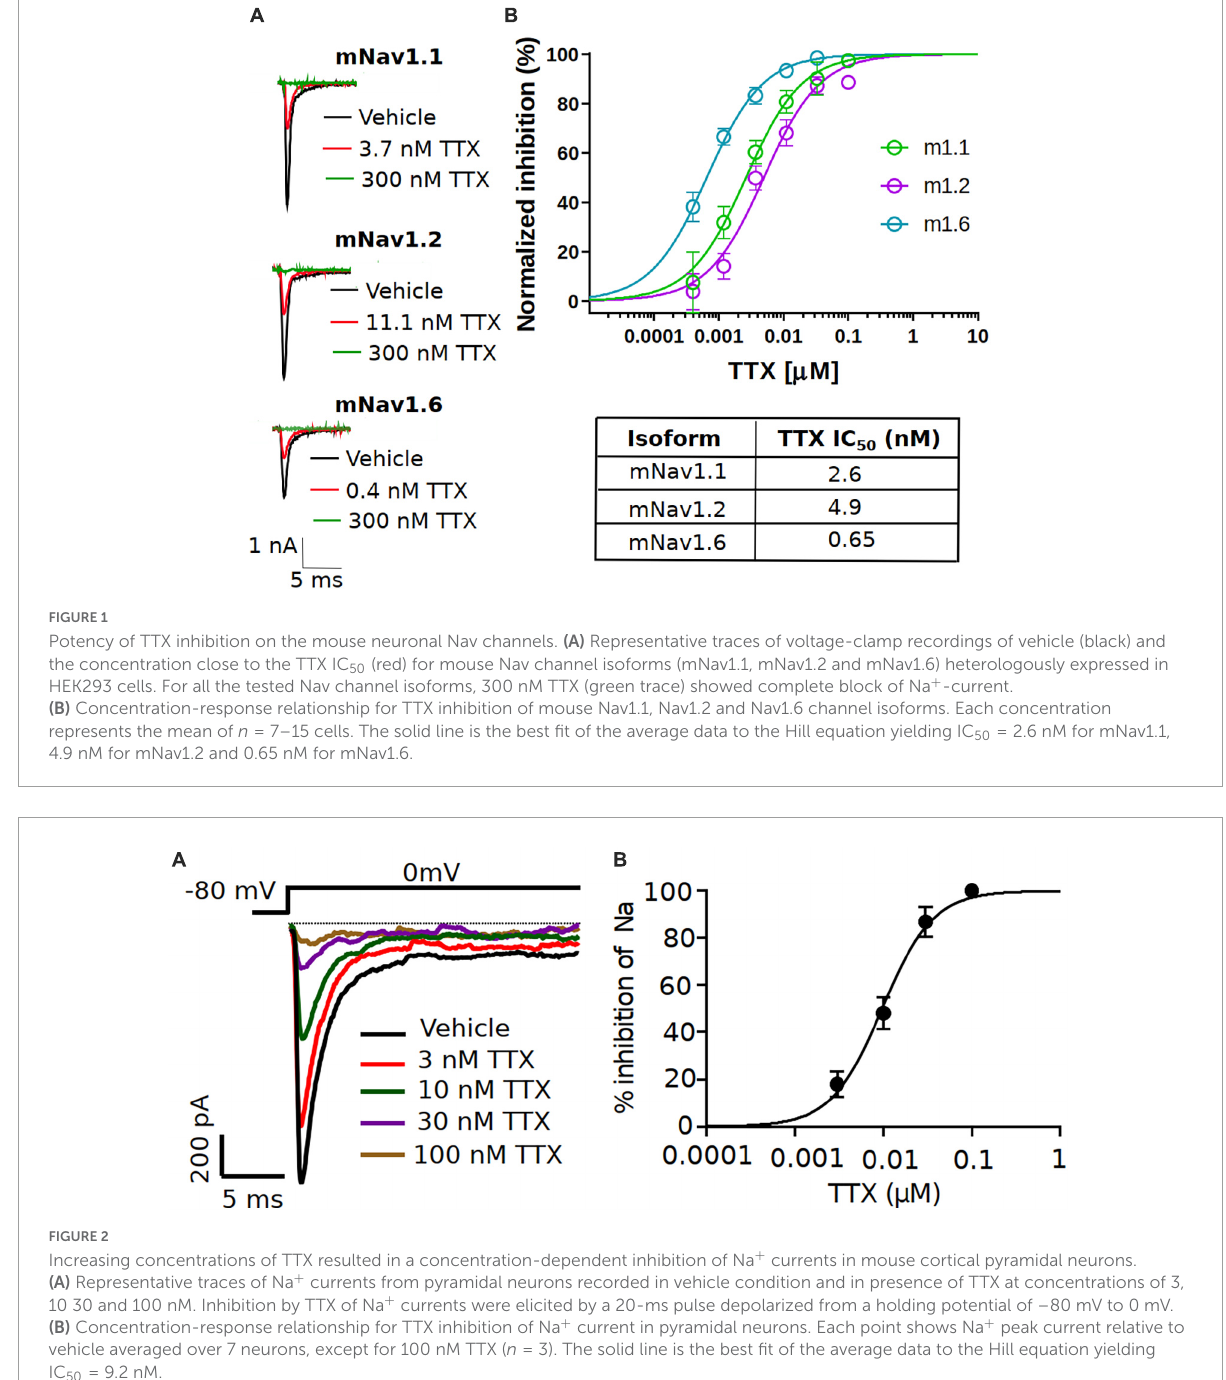
of 10 nM TTX increased significantly the rheobase (vehicle: 112 ± 25.7 pA, n = 9; 10 nM TTX: 170 ± 15.1 pA, n = 7, p < 0.05, Figure 3D ) and AP threshold (vehicle: − 41.4 ± 1.3 mV, n = 9; 10 nM TTX: − 36.1 ± 1.7 mV, n = 7, p < 0.05, Figure 3F ) whereas the AP amplitude (vehicle: 63.0 ± 3.2 mV, n = 9;